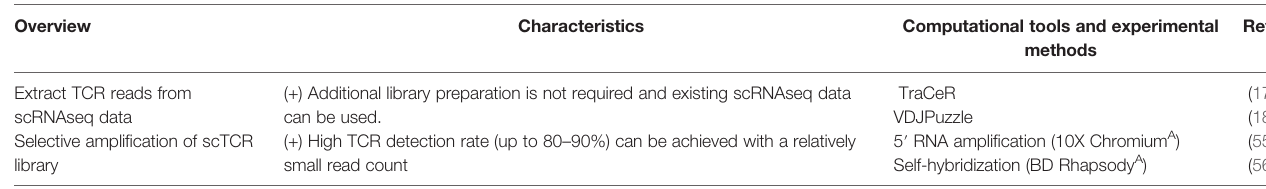
TABLE 5 | Classi fi cations of TCRseq methods and their characteristics. Overview Characteristics Computational tools and experimental